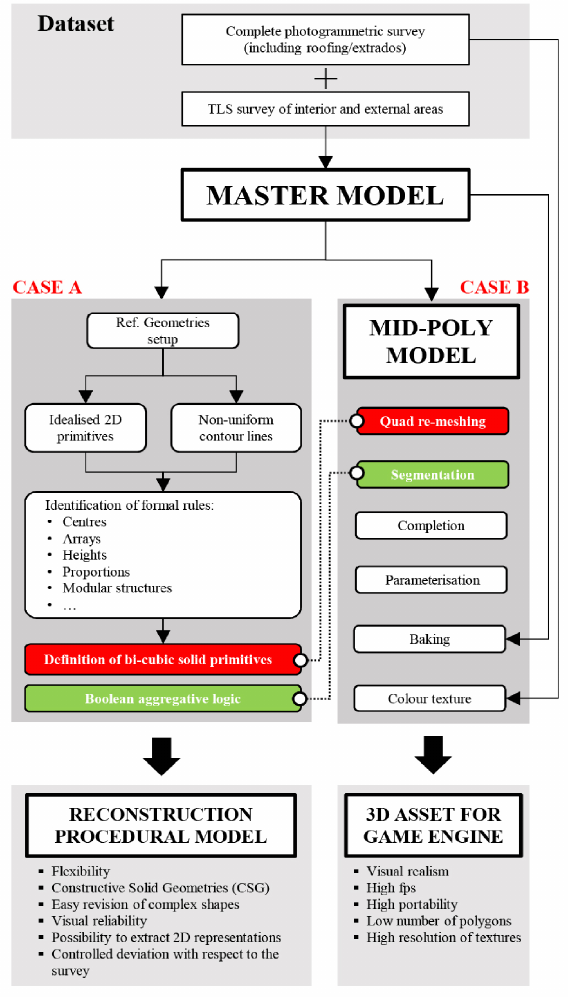
Figure 1. Outlined